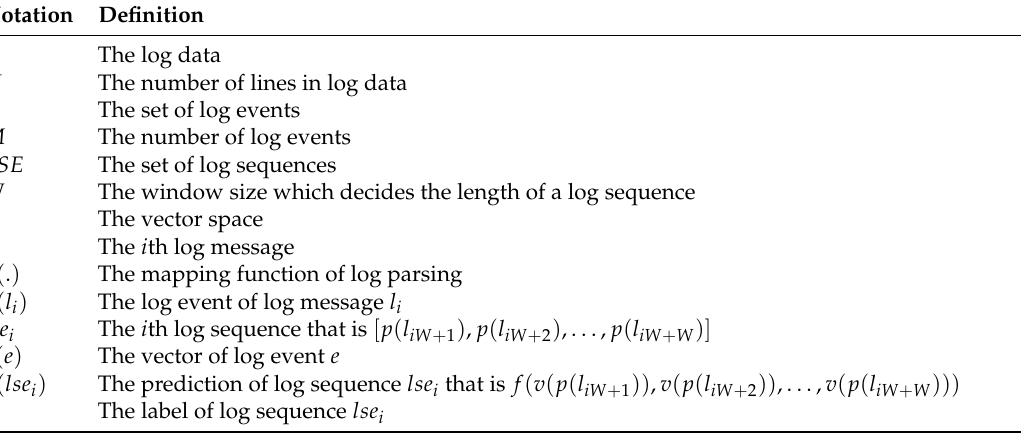
Figure 1. The framework of log anomaly detection. Table 2. List of